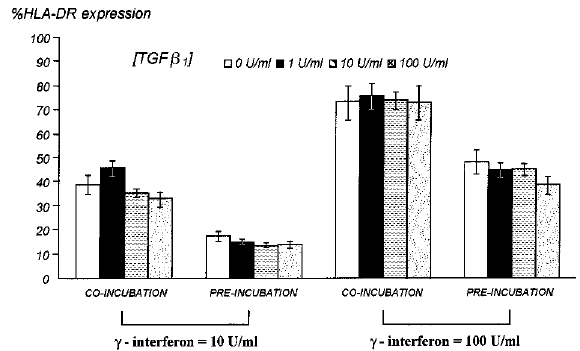
FIG. 2. The effect of transforming growth factor g -1 on g -interferon induced HLA-DR expression. (The error bars represent ±1 standard deviation.) For all ANOVA, P -value >0.05.